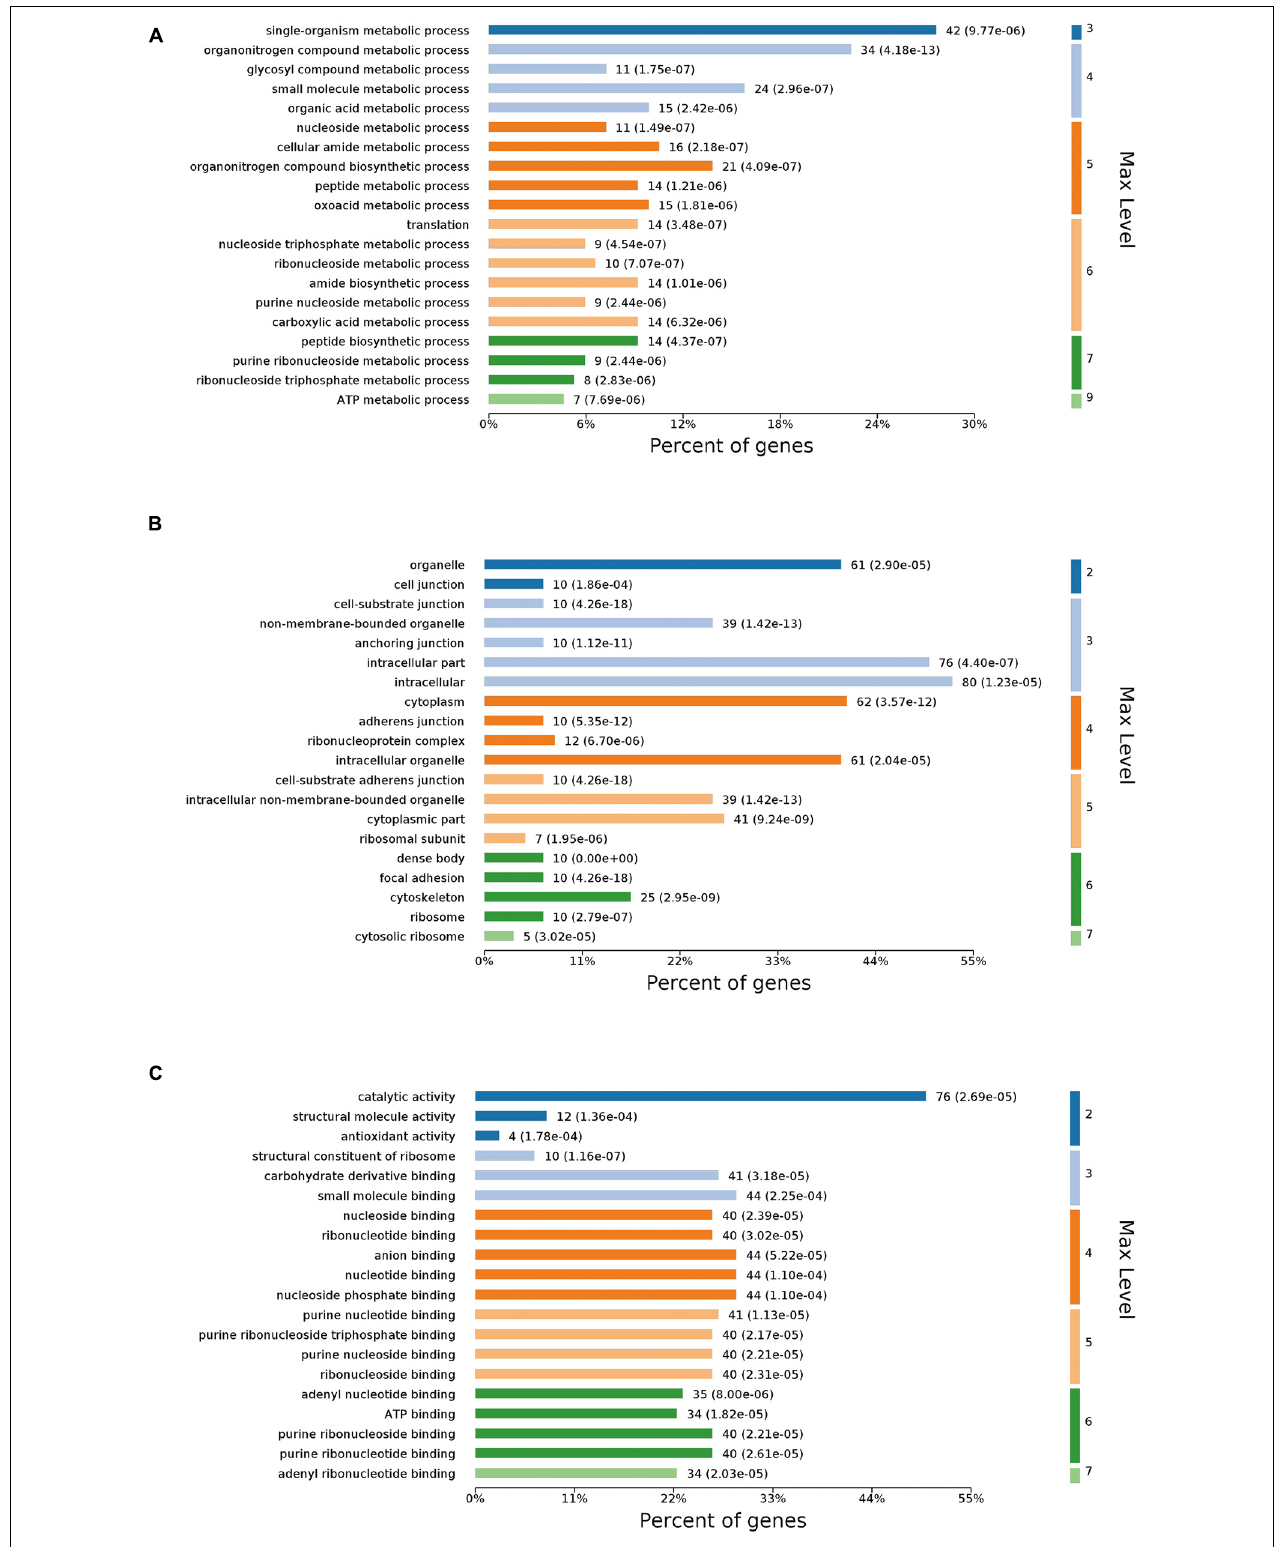
FIGURE 4 | GO annotation of DEPs. DEPs were assigned to second-tier GO categories associated with three terms: biological process (A) , cellular component (B) , and molecular function (C) .